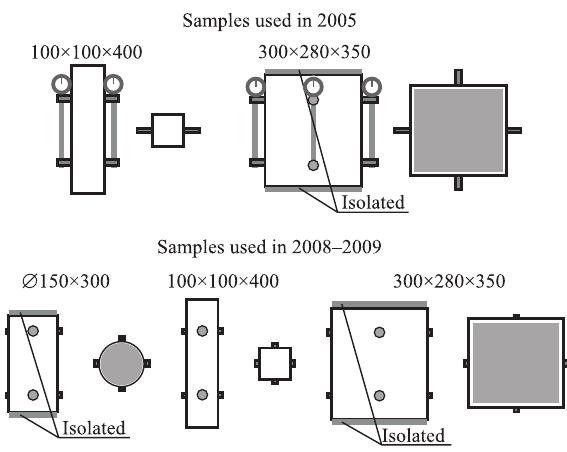
Fig. 4. Experimental set-up of the test specimens